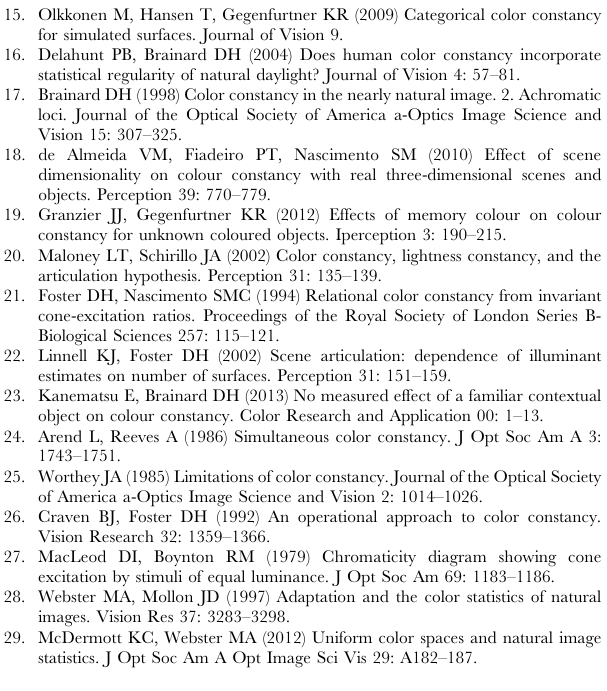
Figure S1 Histograms of changes in cone-opponent channel excitations of 95 distinct background locations between D67 and the bluer, redder, greener and yellower illuminations ± 18 D E uv away in the grey background condition, in modified MacLeod-Boynton (McB) coordinates.